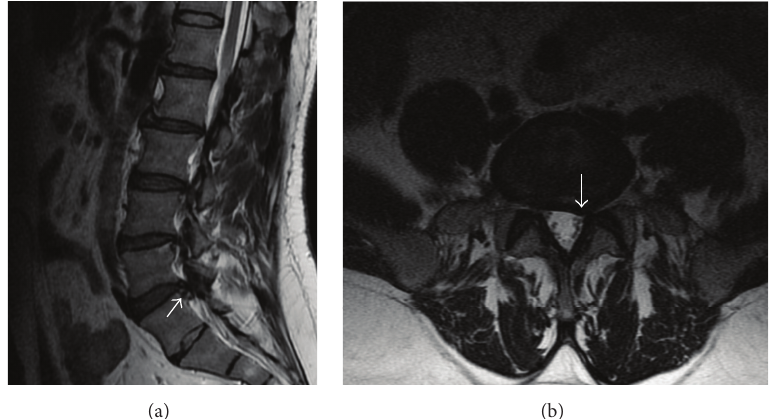
Figure 1: An extruded disc herniation that slightly migrated downward at L5-S1 level on T2 weighted sagittal (a) and axial (b) MR images after 3